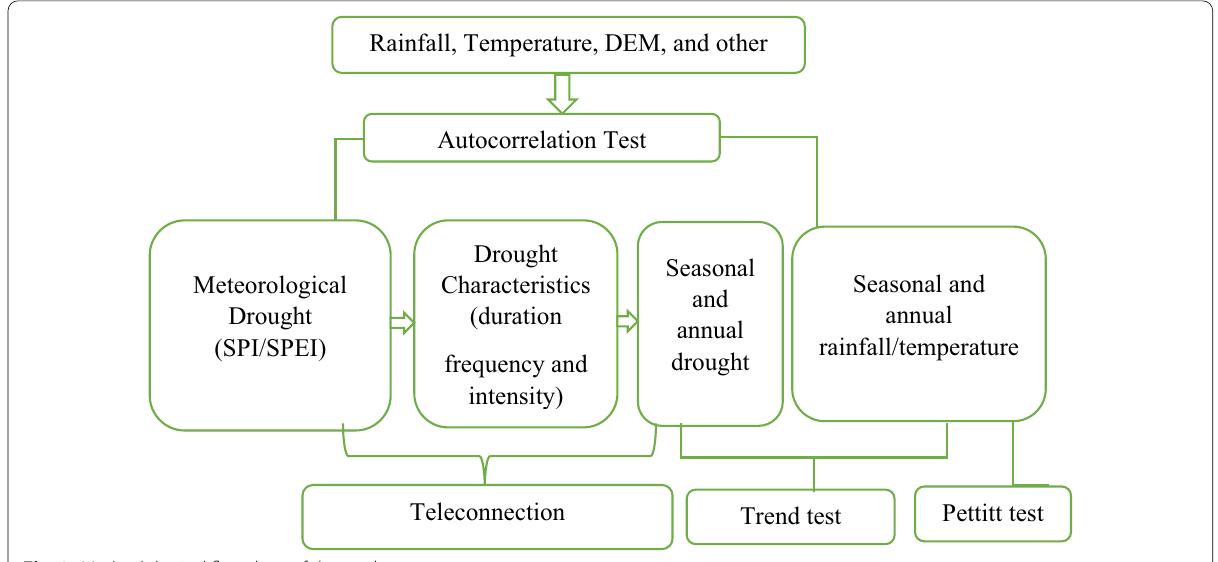
Fig. 3 Methodological flowchart of the